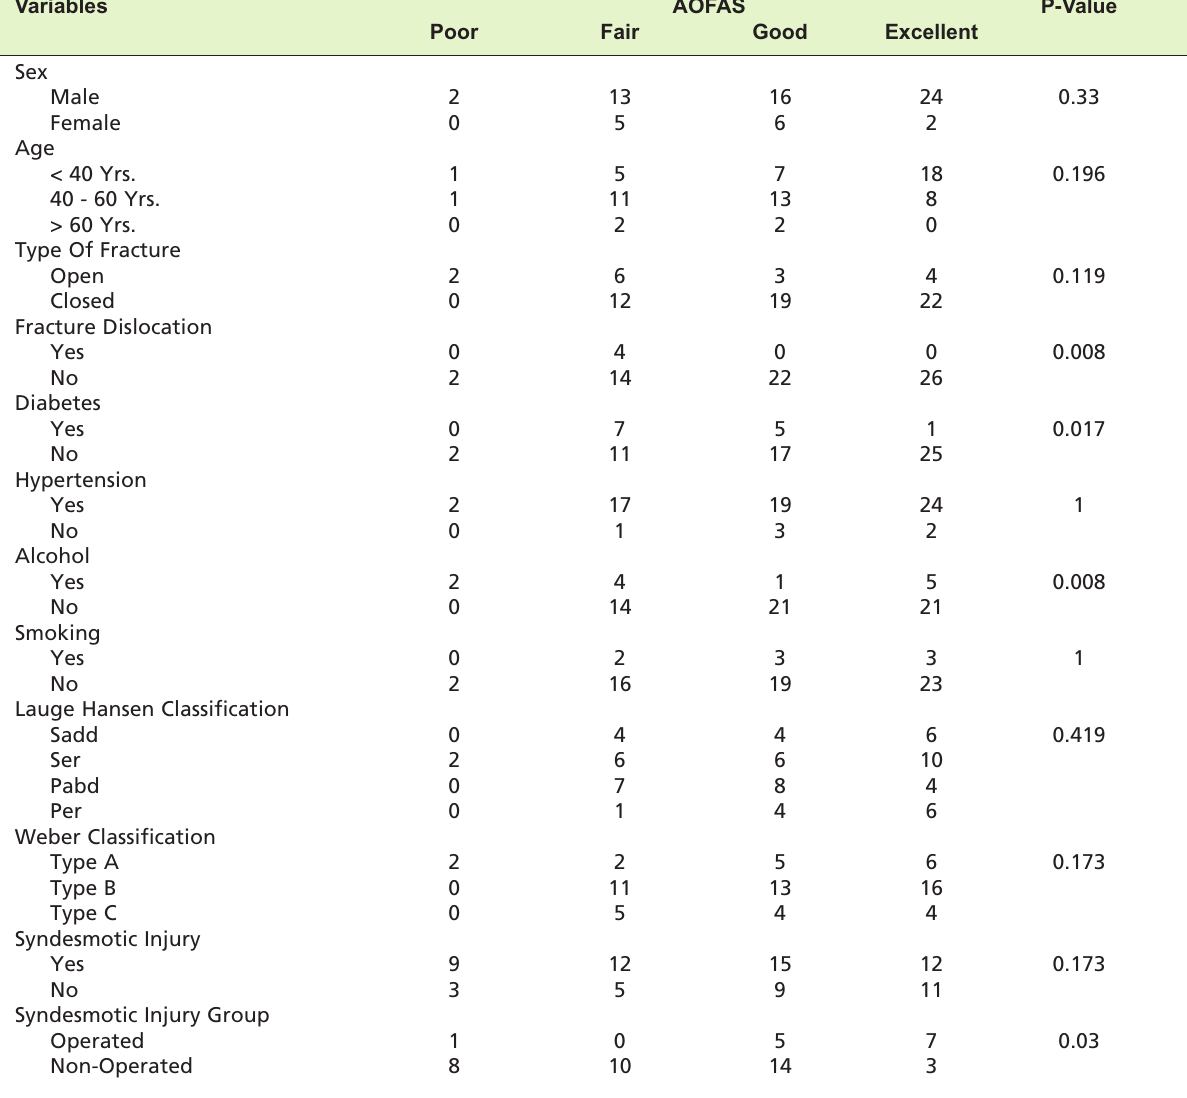
Table showing the variables that affect the AOFAS Table I: